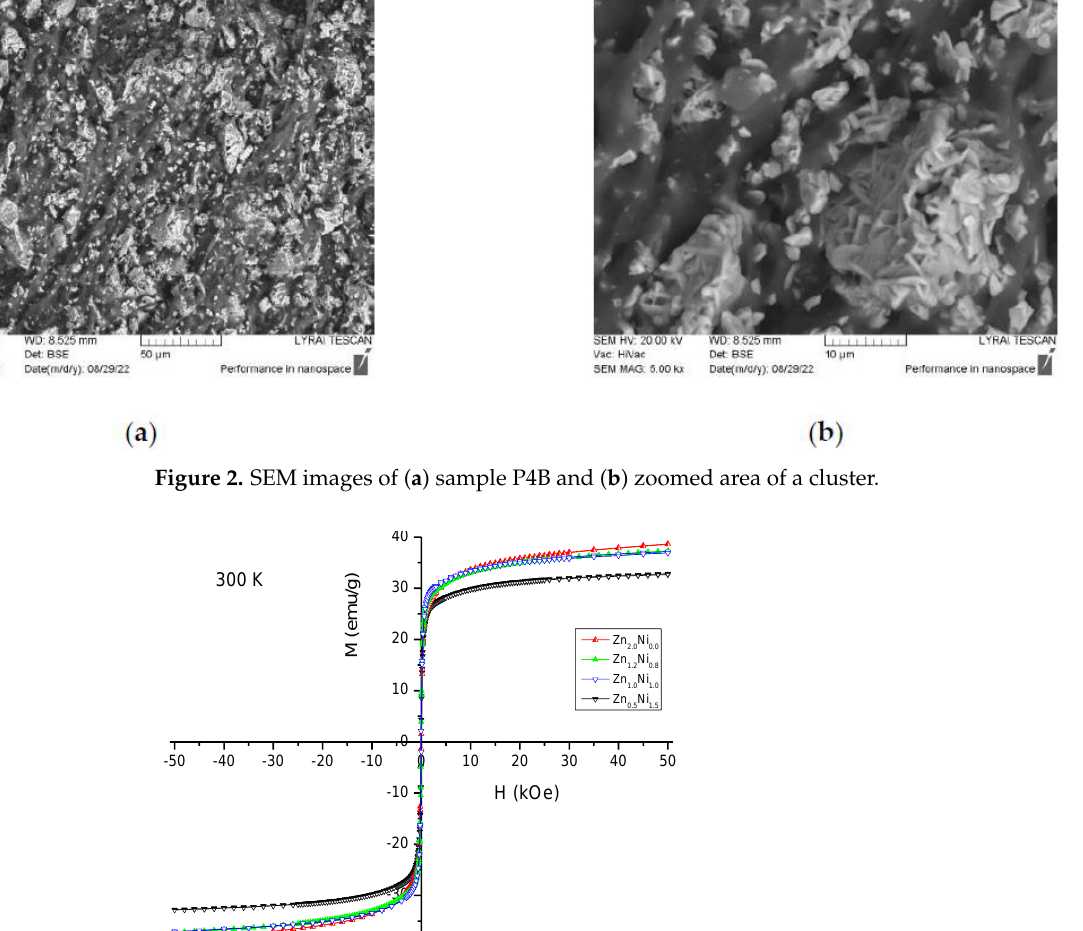
Table 1. Magnetization values at a magnetic field of 50 kOe for the samples depending on the Zn:Ni cation ratio.